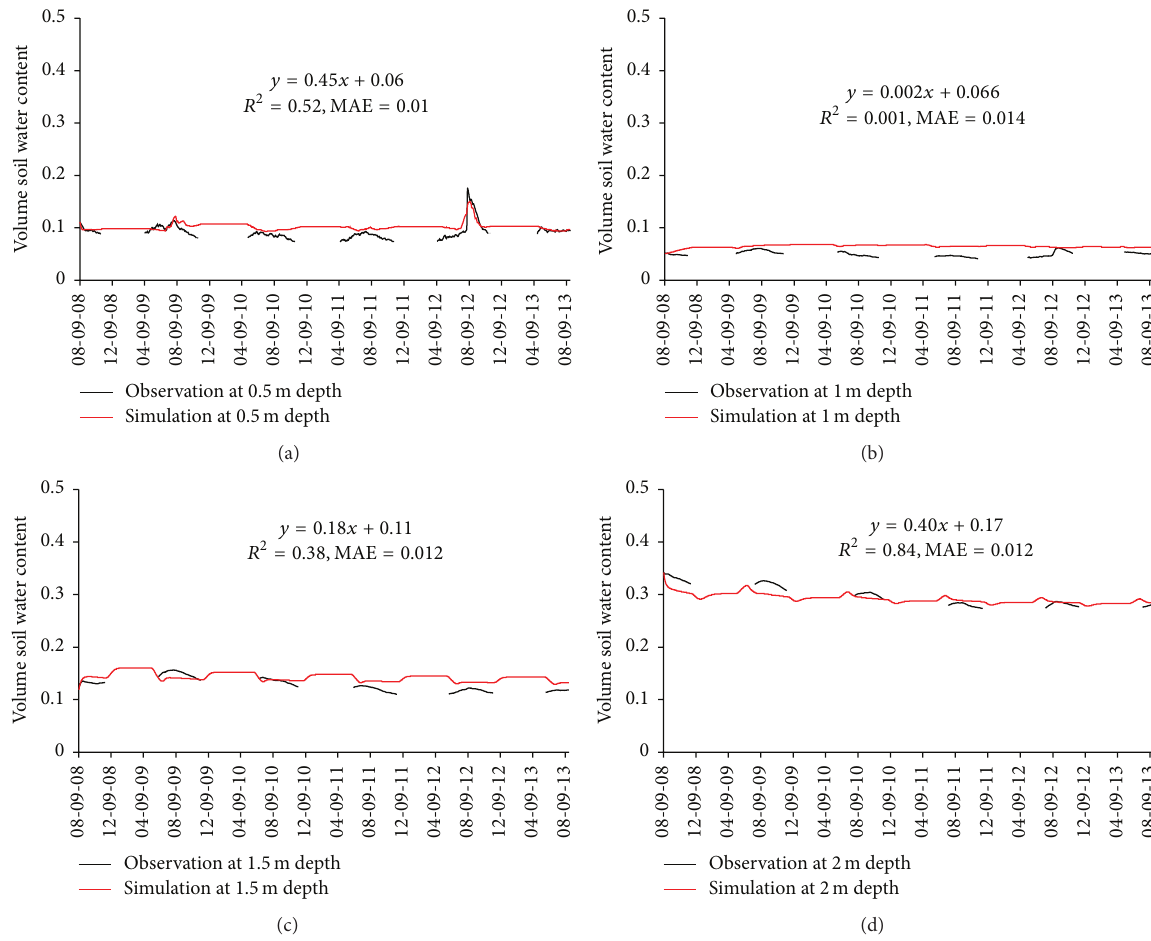
Figure 3: Comparison of simulated and observed soil water content at the depths of 0.5 m, 1m, 1.5m, and 2 m, respectively. A linear analysis was conducted for each comparison, where 𝑅 2 is the coefficient of determination and MAE is the mean absolute